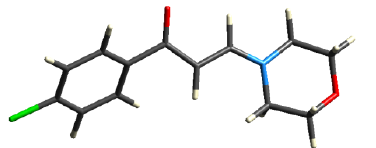
Figure 2. Percentages of intermolecular interactions in compounds 1 , and 2 .